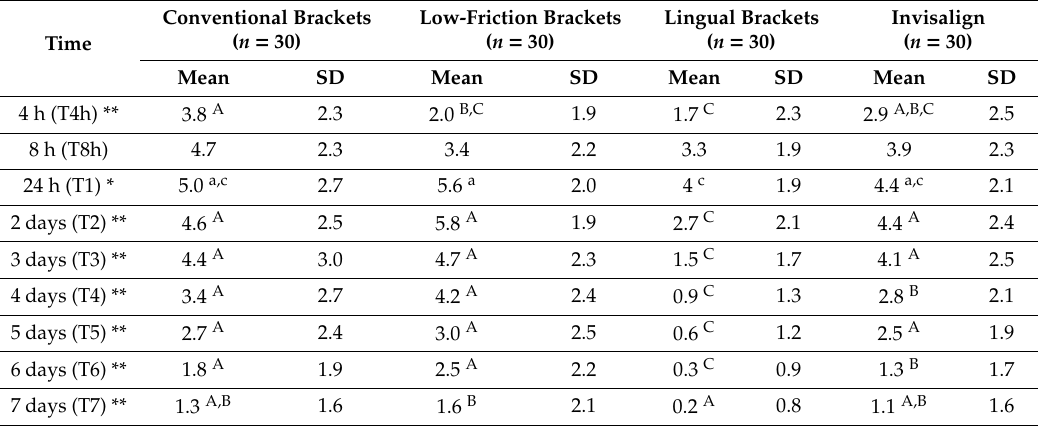
Table 2. Comparison of dental pain on the visual analog scale between groups at the different evaluation times ( n = 120).